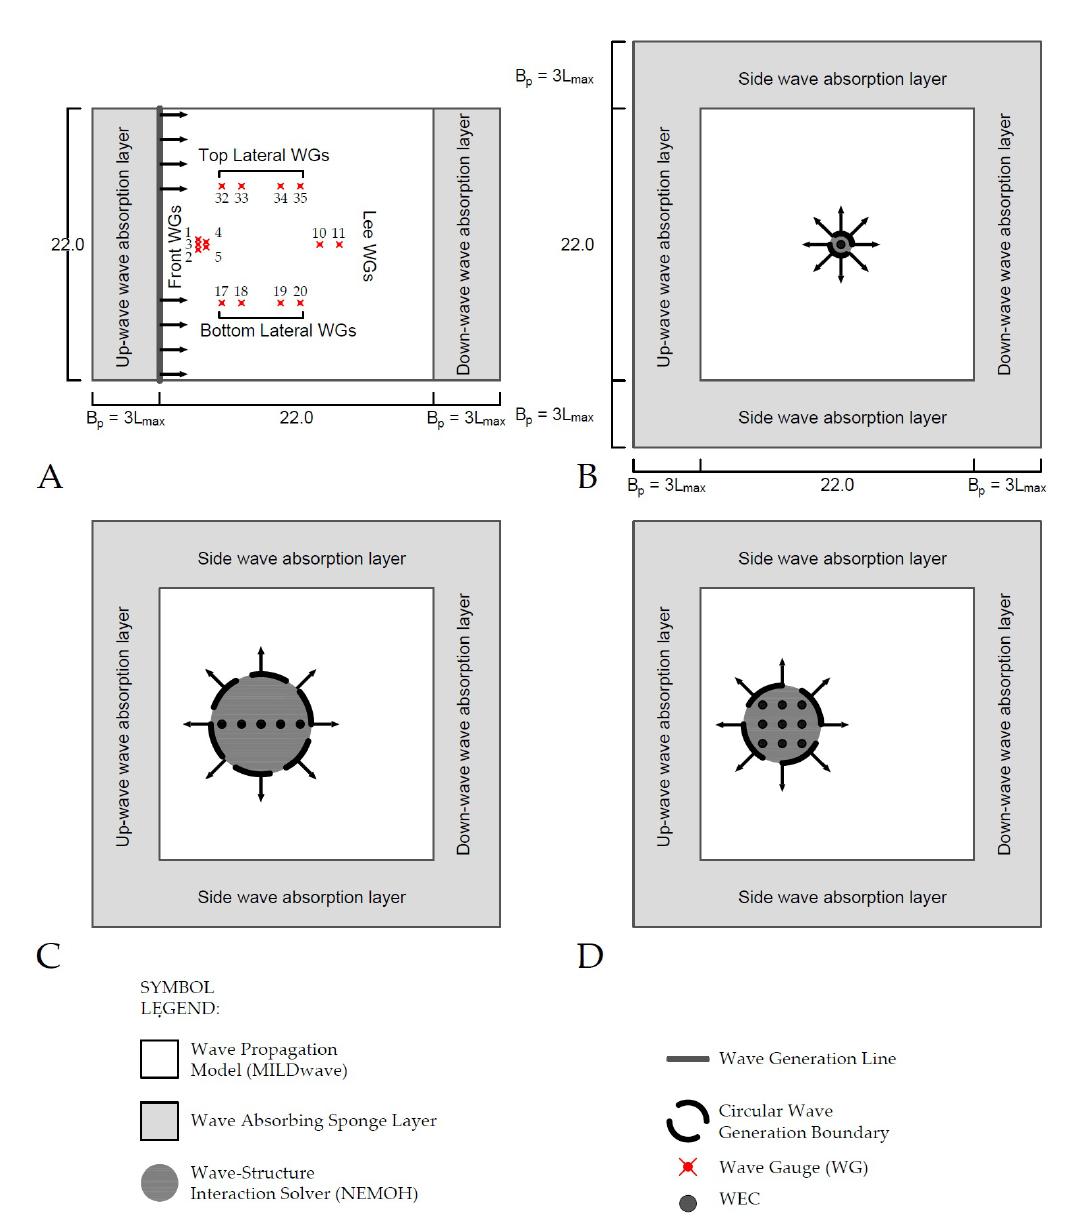
Figure 1. Set-up of the different numerical wave basins used in MILDwave. The wave gauges (WGs) are represented by the x symbol and numbered as they appear in the WECwakes experimental data-set. ( A ) empty numerical wave basin and layout of WGs; ( B ) numerical wave basing with a single WEC; ( C ) numerical wave basin with an array of five WECs (1 column, 1 × 5); ( D ) numerical wave basin with an array of nine WECs (3 columns and 3 rows, 3 ×